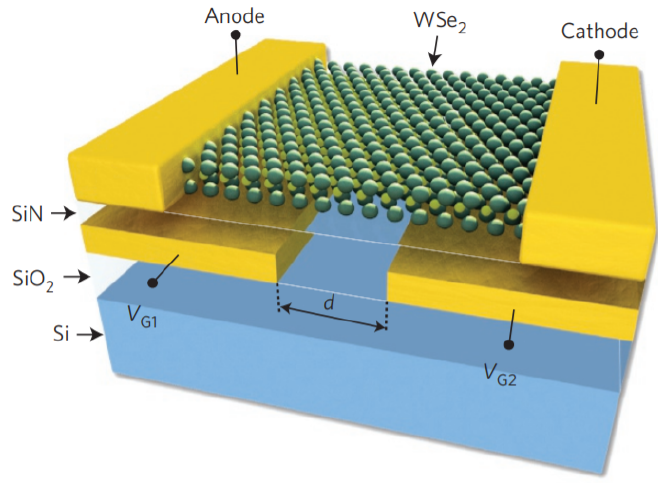
Figure 6. WSe 2 monolayer device with split gate electrodes (Reproduced with permission from ref. [95]. Copyright 2014 Springer Nature Publications).